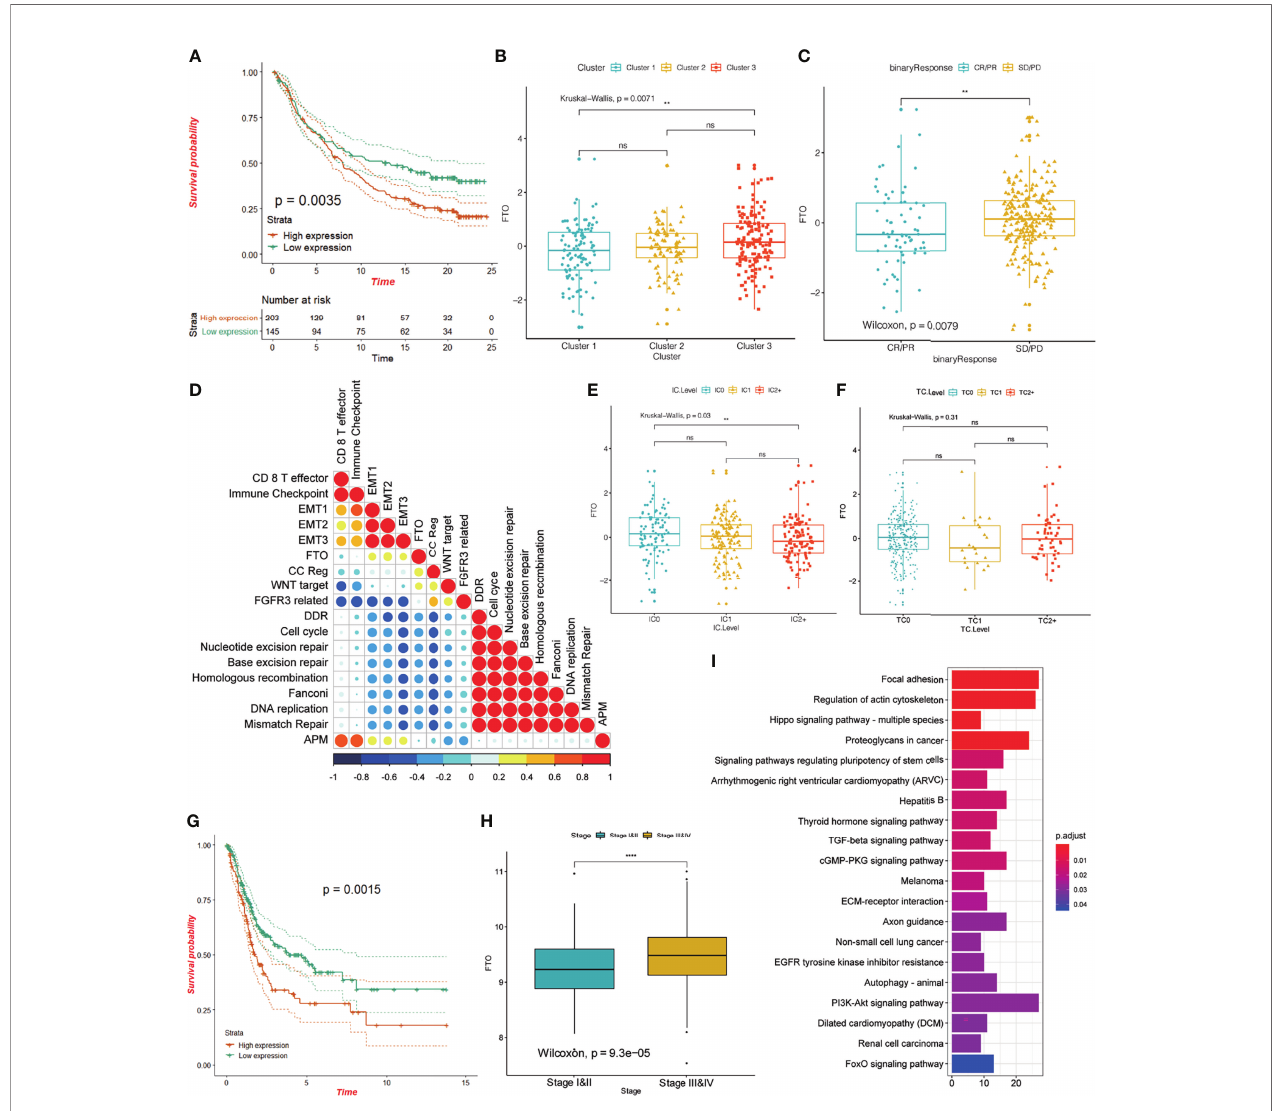
FIGURE 9 | Characteristics of FTO in the TCGA-BLCA cohort and anti-PD-L1 treatment cohort. (A) KM curve showing the effect of FTO on OS in the IMvigor 210 cohort. (B) The difference in FTO expression among the three different m 6 A modi fi cation patterns in the IMvigor 210 cohort; the asterisk represents the statistical p- value (**P < 0.01; ****P < 0.0001, ns P > 0.05). (C) The difference in FTO expression between responders (CR/PR) and non-responders (SD/PD) in the IMvigor 210 cohort; the asterisk represents the statistical p-value (**P < 0.01; ****P < 0.0001). (D) Spearman ’ s correlation was used to analyze the correlation between FTO expression and known gene characteristics in the IMvigor 210 cohort. Blue, negatively correlated; orange, positively correlated; and the larger circle indicates a higher correlation. (E, F) The relationship between FTO expression and PD-L1 expression in immune cells (IC), and PD-L1 expression in tumor cells (TC). The asterisk represents the statistical p-value (**P < 0.01; ****P < 0.0001, ns P > 0.05). (G) KM curve showing the effect of FTO on OS in the TCGA-BLCA cohort. (H) Box plot showing the difference in FTO expression between stage I and II and stage III and IV; the asterisk represents the statistical p-value (**P < 0.01; ****P < 0.0001). (I) Pearson correlation was used to calculate the correlation between FTO and all other protein-coding genes, and genes with a correlation coef fi cient R >= 0.03, and p < 0.05 were selected as FTO -related genes. These genes were enriched by KEGG signaling pathway analysis to study FTO